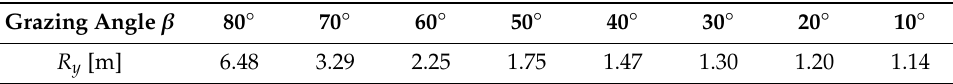
Table 1. Calculated across-track resolution of the ACSON-100 side-scan sonar. Grazing Angle β